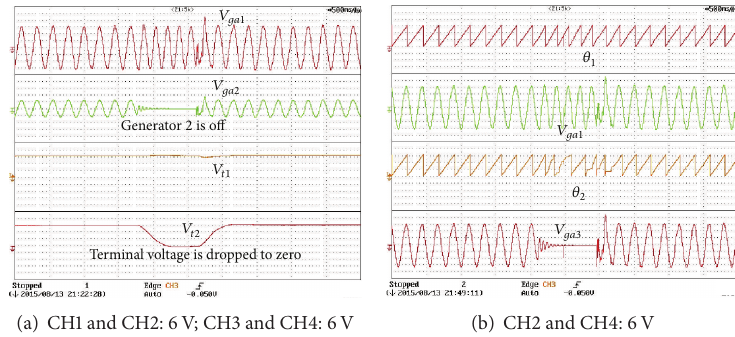
Figure 9: Experimental result on DSO after resynchronization of micro source 2 after fault